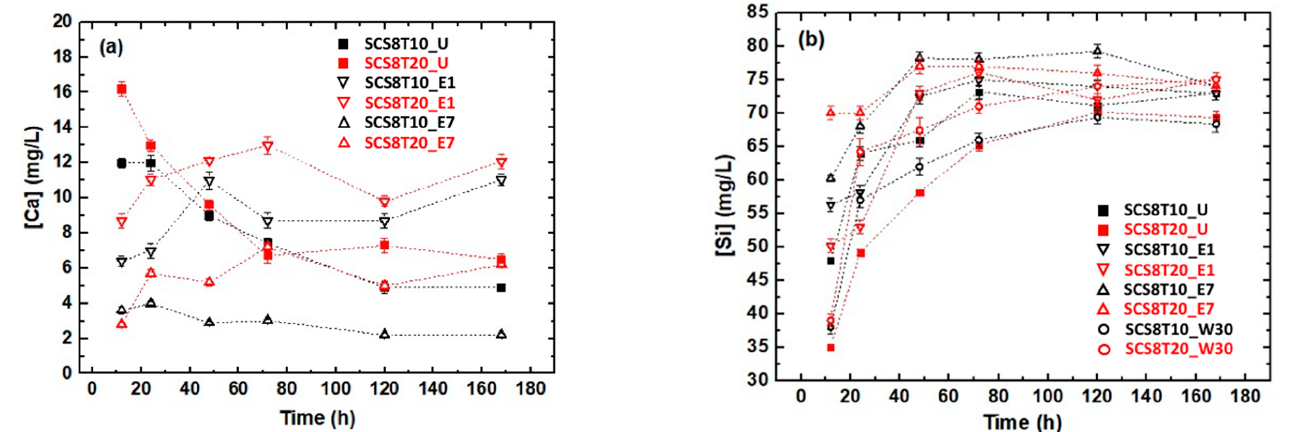
Figure 6. ( a ) Ca and ( b ) Si release from SCS8, SCS8T10, and SCS8T20 xerogels soaked in PBS and previously subjected to U, E1, E7, and W30 washing treatments before evaporative drying.